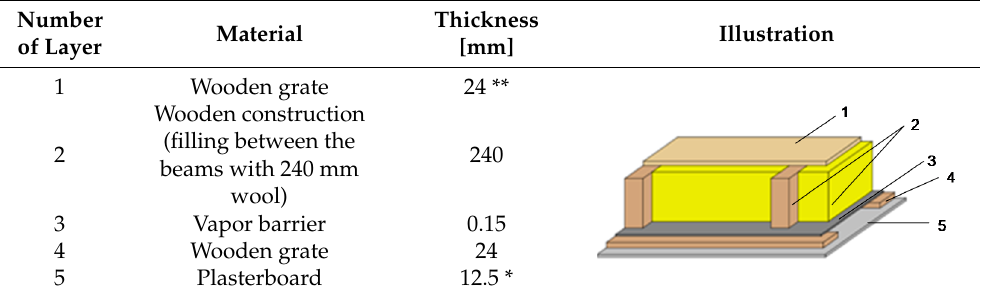
Table 3. Ceiling above the attic, Wolf system.